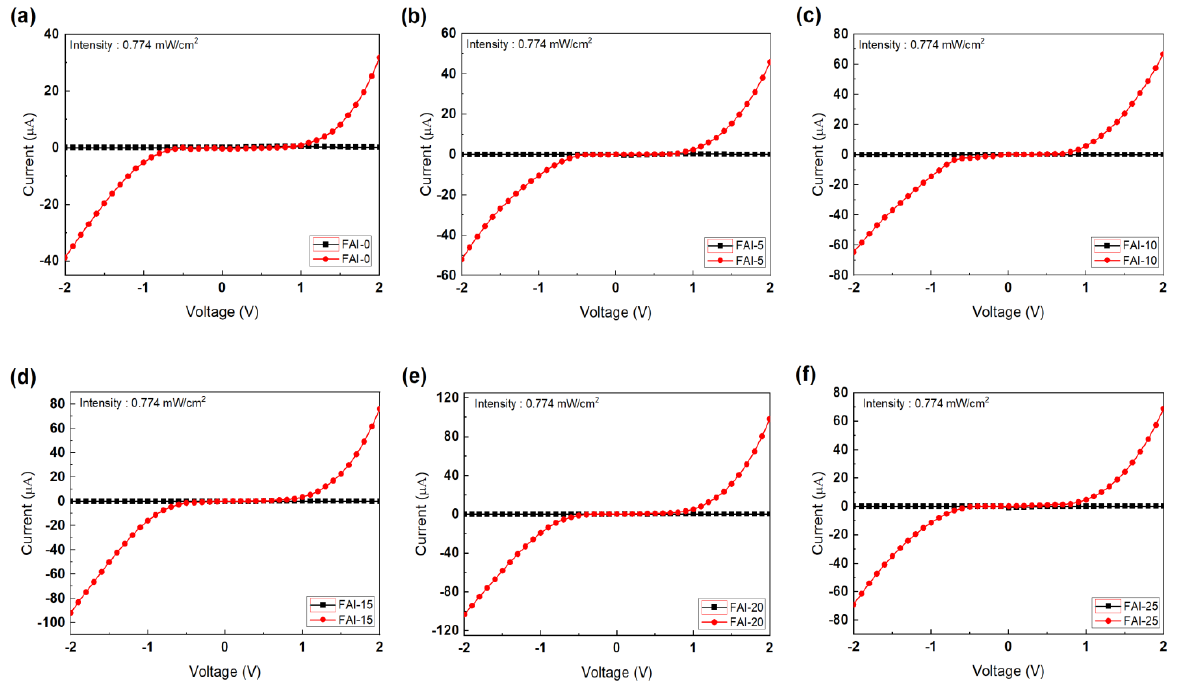
Figure 5. Current – voltage (I – V) characteristics of the FA x MA 1 − x PbI 3 perovskite UV PDs post-treated with different FAI concentrations. ( a ) FAI-0, ( b ) FAI-5, ( c ) FAI-10, ( d ) FAI-15, ( e ) FAI-20, and ( f )